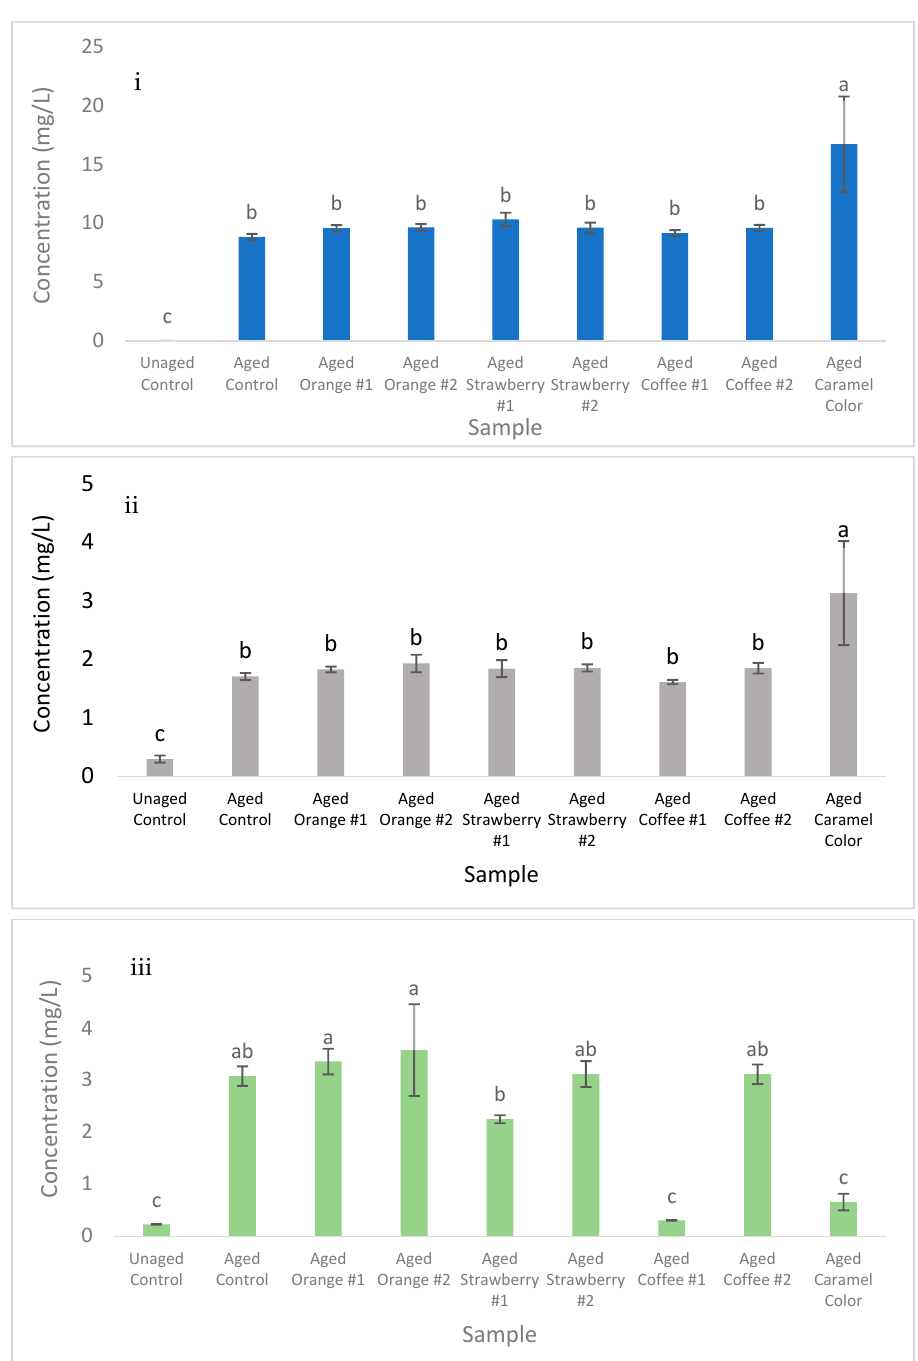
Figure 4. Quantification of rebaudioside A degradation compounds 1 ( i ), 2 ( ii ), and 3 ( iii ) in unaged and aged (6 weeks, 35 °C) acidified aqueous samples consisting of rebaudioside A (control samples) or rebaudioside A with different flavors (two orange, two strawberry, two coffee) and color (caramel). Different letters indicate significant differences at α = 0.05 Tukey HSD.